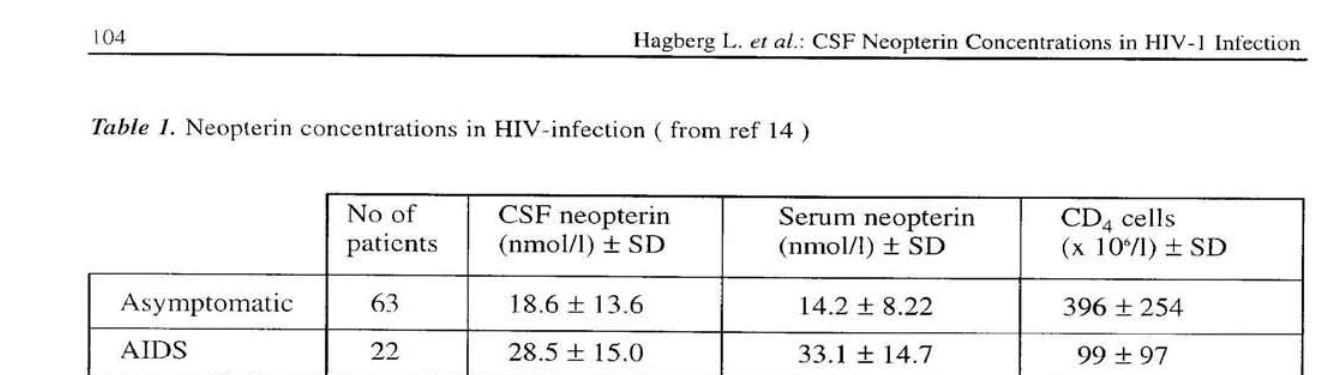
Table 1. Neopterin concentrations in HIV-infection ( from ref 14 )